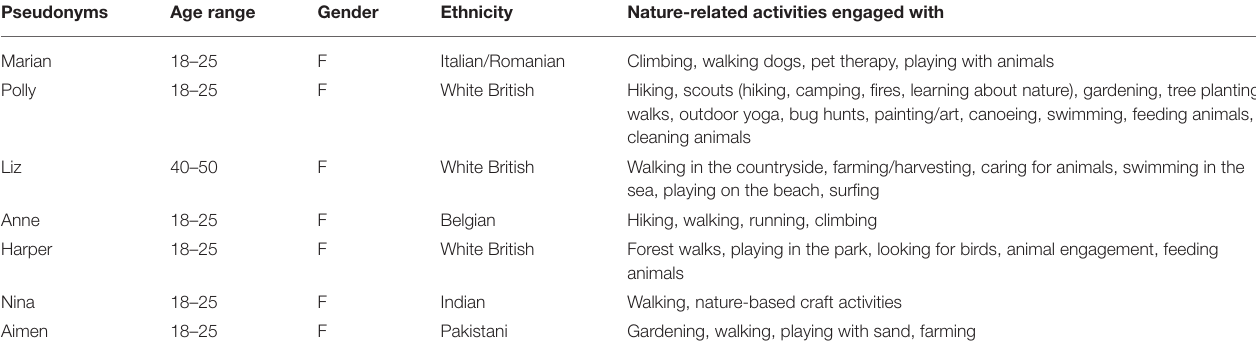
TABLE 3 | Participants’ characteristics.